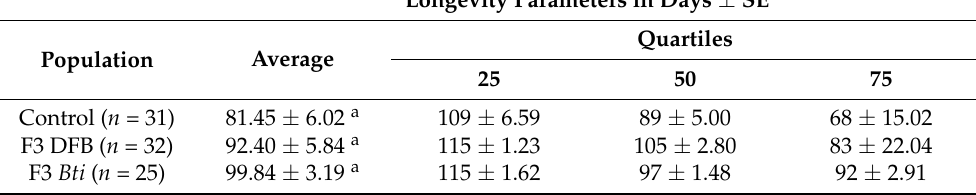
Table 6. Post-overwintering longevity parameters of Cx . pipiens f. pipiens populations that were either selected against diflubenzuron (DFB) and Bti for three successive generations or not (control). Females were maintained at the same place (warehouse) where they overwintered, having access to 10% sugar solution. Different letters indicate significant differences (pairwise comparisons log-rank test, p <